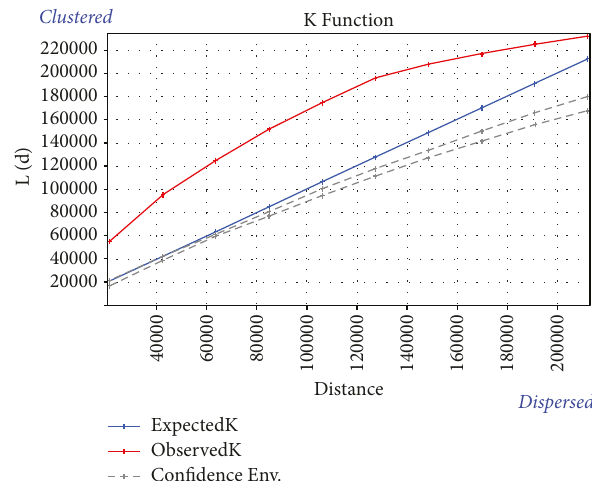
Figure 2: Ripley’s K function of characteristic town in Guangdong Province.